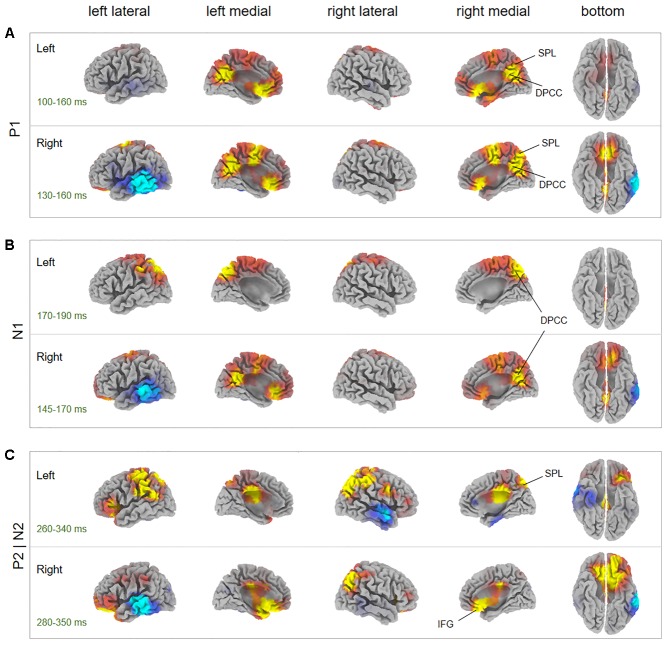
Between-subject comparisons for image-elicited ERP sources. The t-score maps for the comparison between AHAs and HCs for P1 component (A), N1 component (B), and P2 and N2 component (C) are shown for drug-related cues presented in the left and right visual fields, respectively. The brain regions with yellow/red color indicate AHAs > HCs, whereas green/blue color indicates AHAs < HCs. The time periods for different components are indicated as well. To be noticed, the time window for P2 and N2 components are overlapping. Significant brain regions (p < 0.05, FWE corrected) were indicated on the map. The peak MNI coordinate regions for each comparison are reported in Table 1. dPCC, dorsal posterior cingulate cortex; IFG, inferior frontal gyrus; SPL, superior parietal lobule.